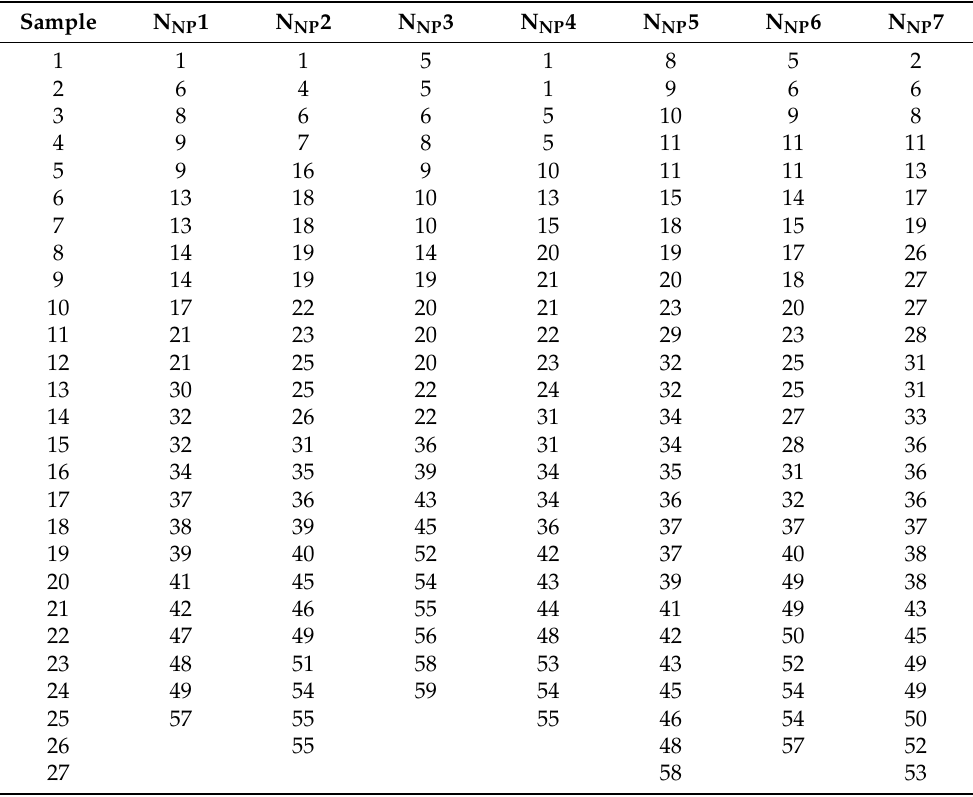
Figure 11. Detection results of the 7 networks. Table 2. Cases that were mistakenly detected by the numerical